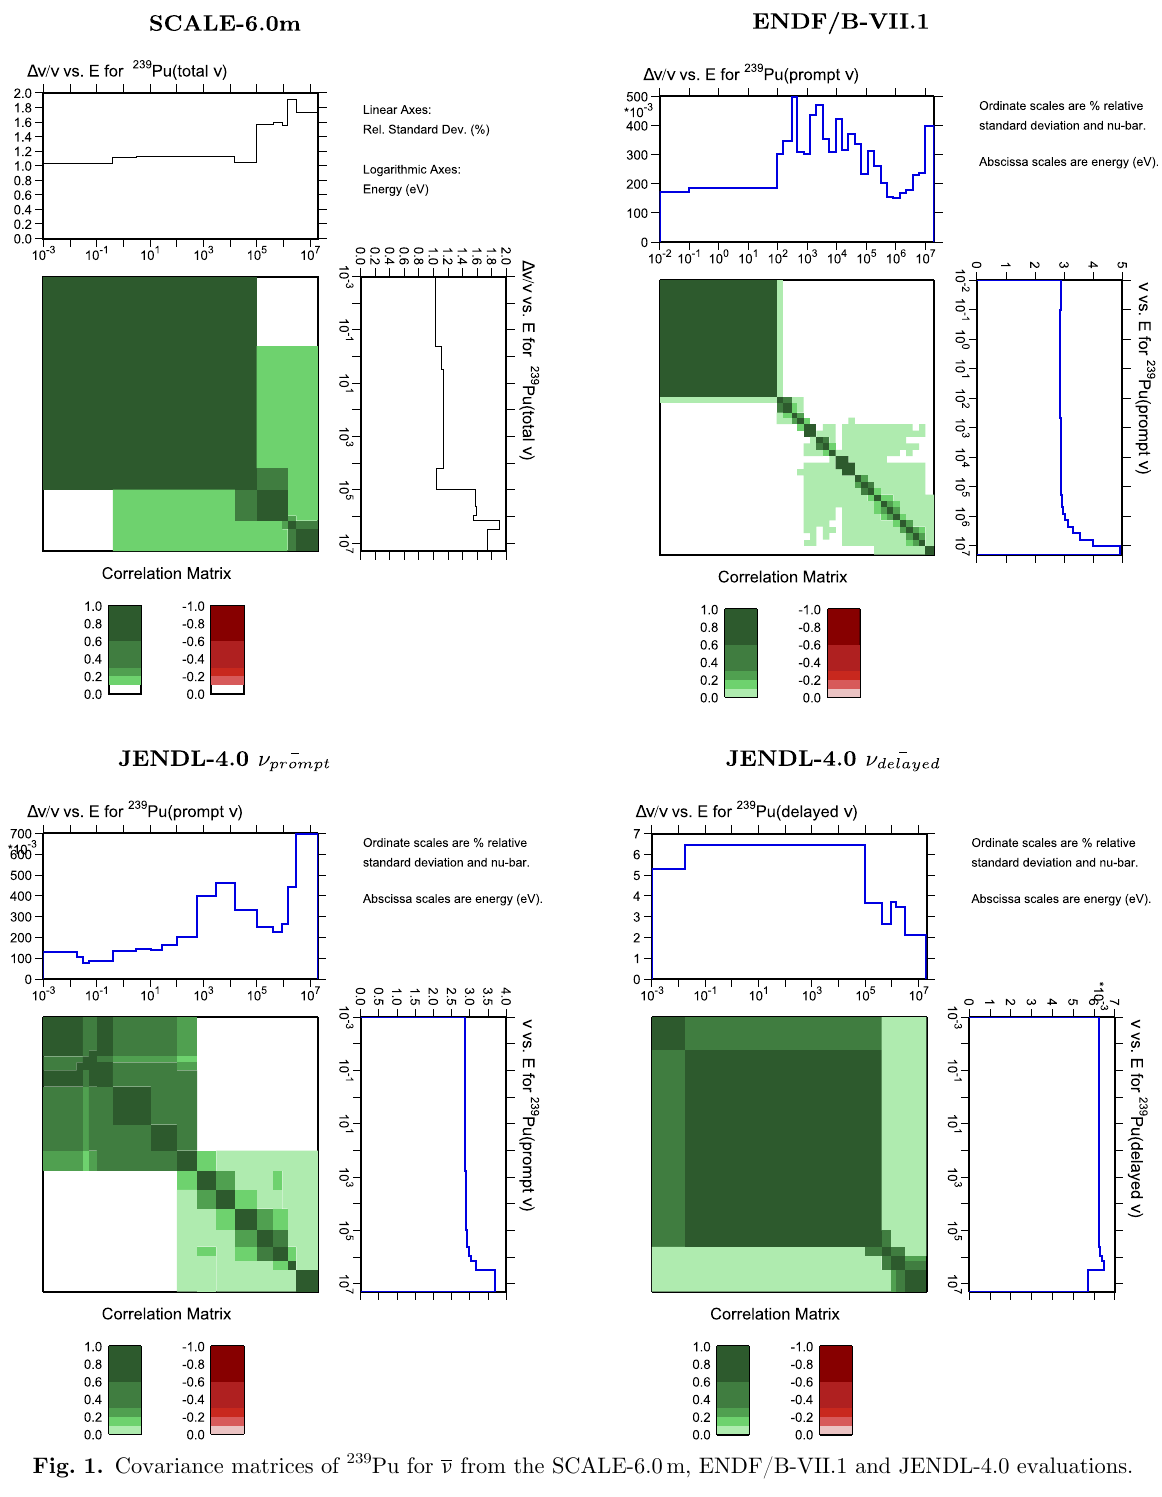
Fig. 1. Covariance matrices of 239 Pu for n from the SCALE-6.0m, ENDF/B-VII.1 and JENDL-4.0